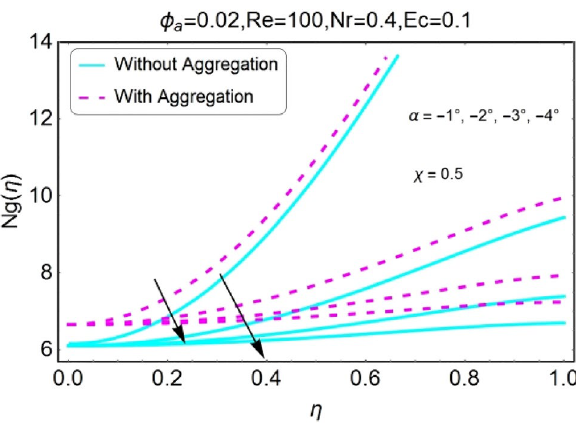
Figure 35. α varying entropy for stretching walls (convergent channel).